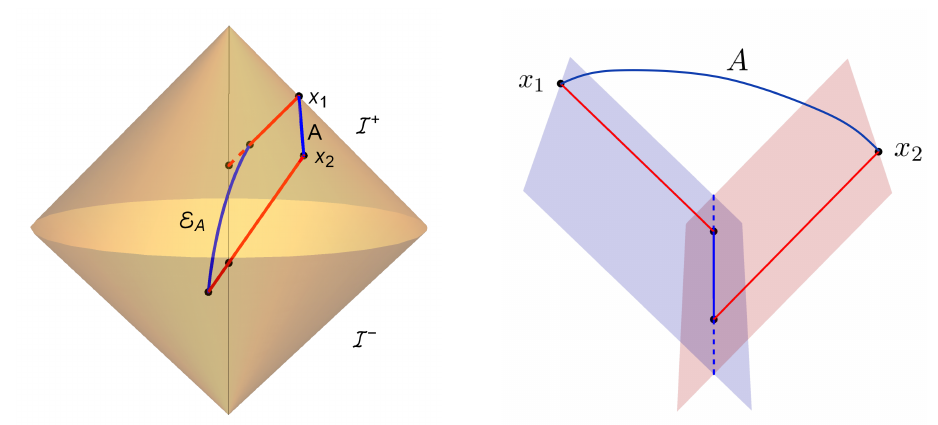
Figure 7: In the left figure, we consider an interval A on the future null infinity I + . The red lines are the null geodesics γ along the r direction emanating from the 1,2 endpoints x . The solid blue line E is the RT surface which is the saddle geodesic A 1,2 with minimal length among all the bulk geodesics connecting γ . The right figure 1,2 shows the same geometric picture in Cartesian coordinate coordinates where all the geodesics are straight lines. The two planes are the two normal null hypersurfaces N ± emanating from E A